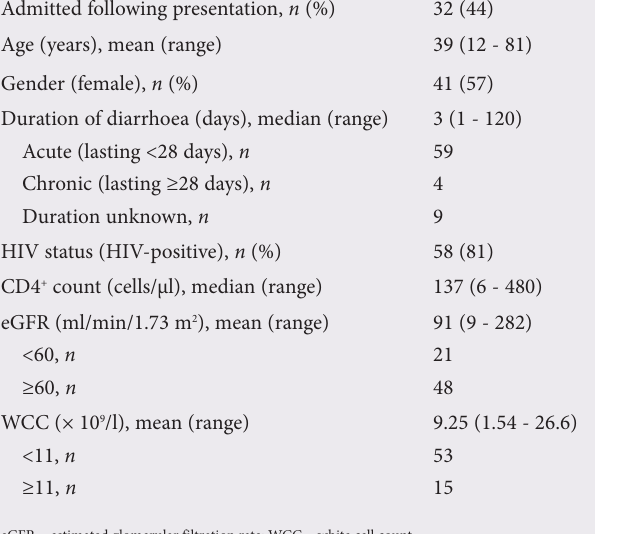
Table 1. Demographics of audit population ( N =72)